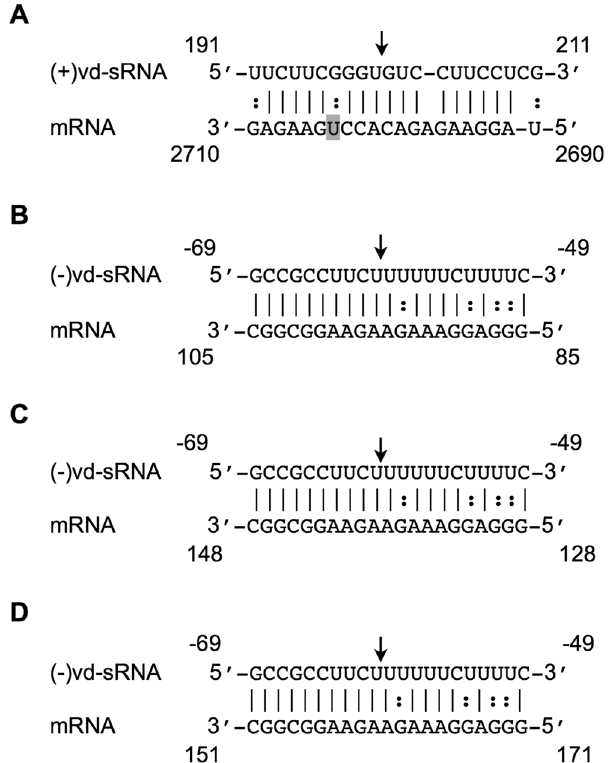
Figure 6. Sequence similarities between the PSTVd-sRNA binding sites of tomato and other host genomes. BLAST analyses were performed against the genomes of both potato and Nicotiana species in order to detect the presence of sequence homologies with both the chloride channel protein CLC-b-like and the RPS3a-like mRNAs of tomato as these species are the hosts of PSTVd under natural and laboratory conditions, respectively. The sequence obtained was aligned against the respective targeting vd-sRNA in order to identify any possible RISC mediated cleavage sites. The vd-sRNA targeting the chloride channel protein CLC-b-like mRNA in tomato was predicted to target ( A ) the potato, but not the Nicotiana species. The tomato and potato c hloride channel protein CLC-b-like mRNAs have one mismatch, which is shadowed. The vd-sRNA RPS3a-like mRNA was predicted to target both the RPS3a-like ( B ) and the cyc07-like mRNAs ( C ) in potato. The same vd-sRNA can also target the RPS3a-like mRNA ( D ) in Nicotiana sylvestris . The arrows indicate the predicted cleavage